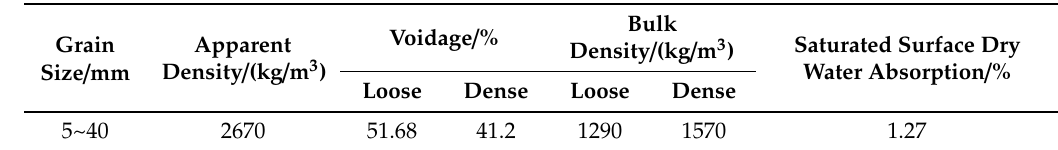
Table 2. Test results of limestone